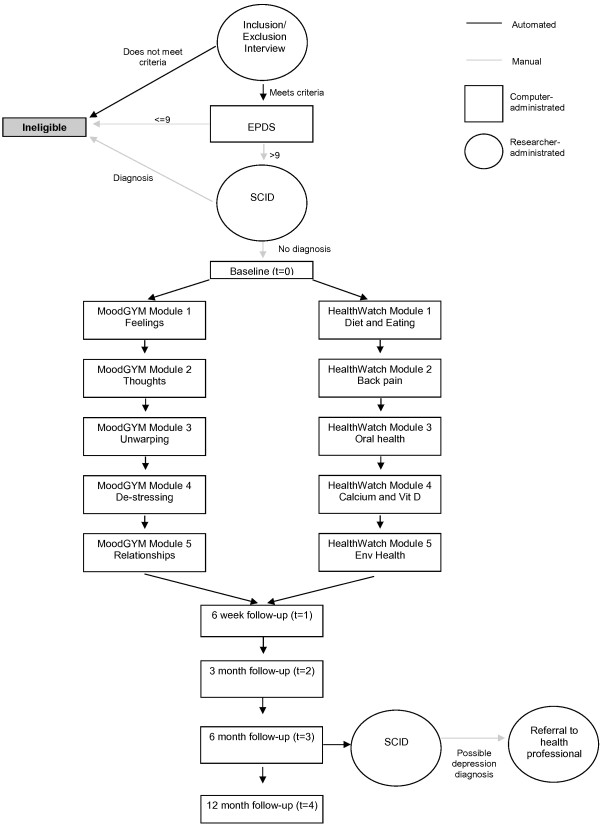
Study flowchart.